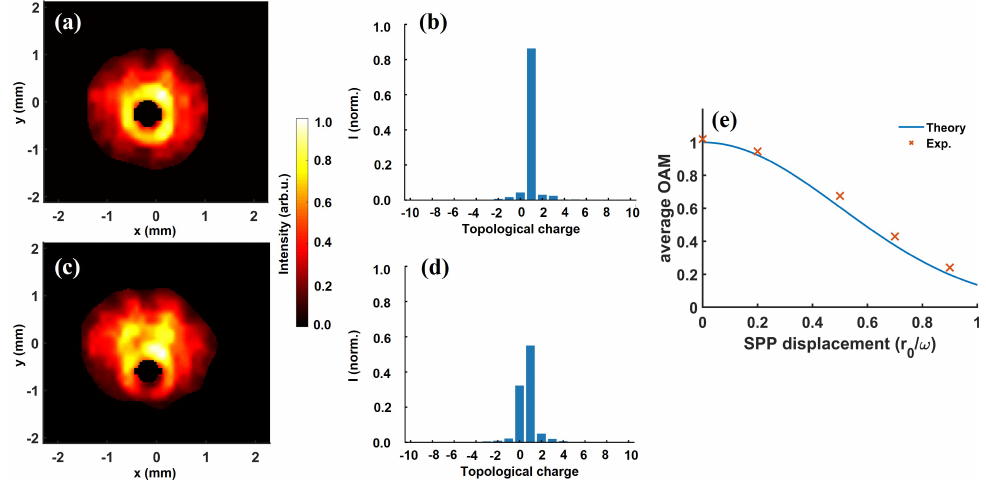
Figure 9. Effect of SPP displacement on the modal composition of (cid:96) = + 1 vortex beam. Intensity (left) and OAM spectra (center) for SPP displacement α = r 0 / ω = 0.2 ( a , b ) and 0.5 ( c , d ). In ( e ), a comparison between theoretical (solid line) and experimental (cross symbol) average OAM for various SPP shifts is presented. The theoretical and experimental results are in very good agreement and indicate the fractional total OAM of asymmetric Gaussian